Question: Identify the chart type used in this figure.
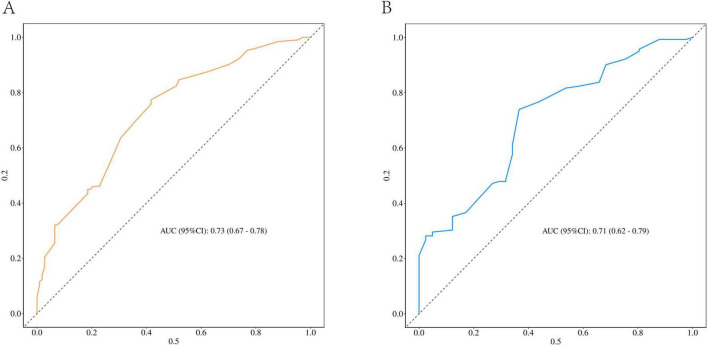
Answer: line